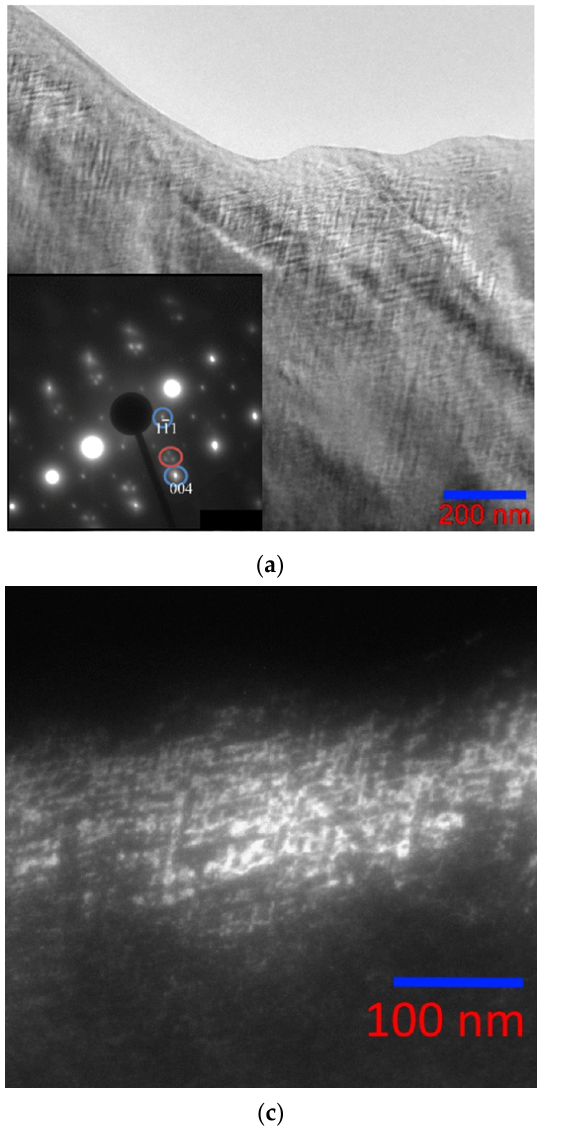
Figure 8. Bright-field ( a ) and dark-field ( b – d ) TEM images of the structure of the Ni 46 Mn 41 In 13 alloy in the austenitic state and the corresponding microelectron diffraction pattern on the inset, obtained from the entire region ( a ), zone axis [110] L21 , ( b ) in reflection (1 1 1) L21 , ( c ) in the reflection (004) L21 , ( d ) in the triplet of reflections).